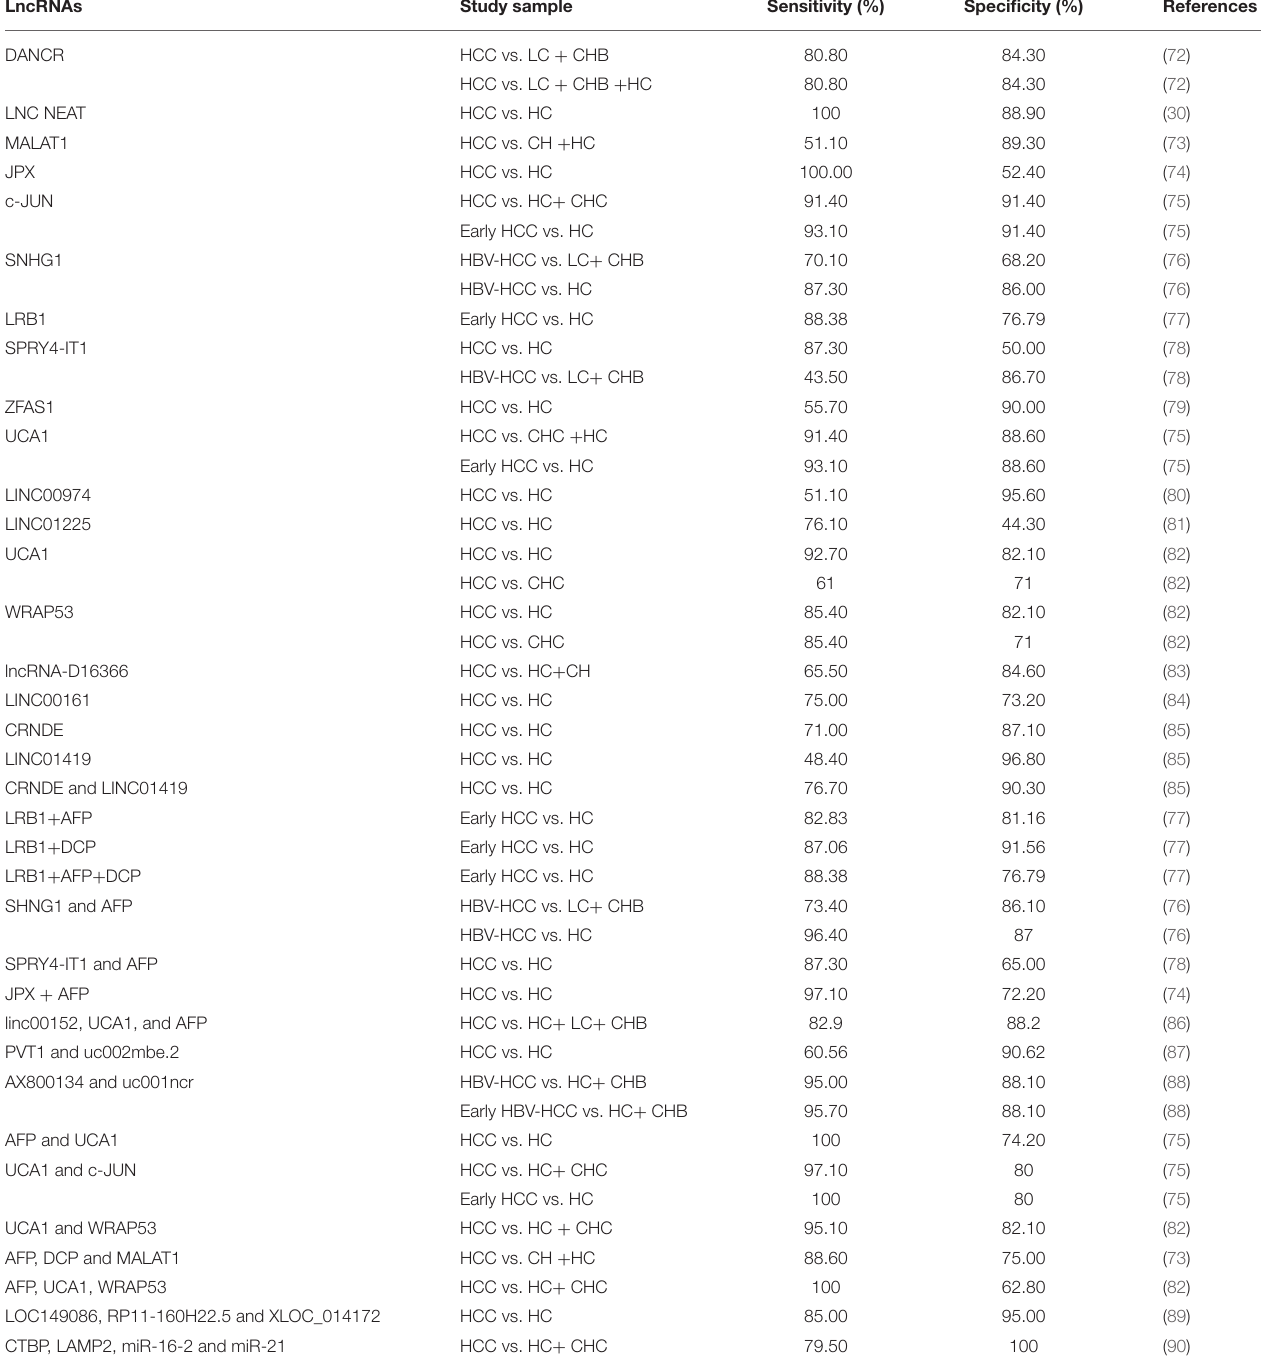
TABLE 2 | Application of lncRNAs as a diagnostic index in hepatocellular carcinoma